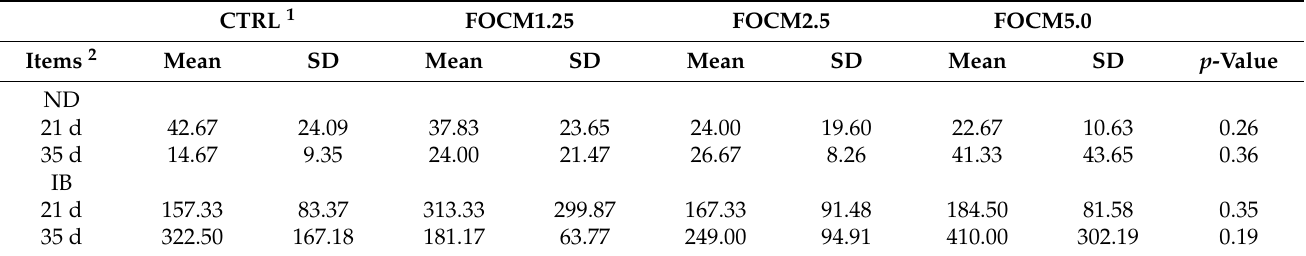
Table 5. Effect of FOCM supplemented in diet on antibody titration of serum in broilers.